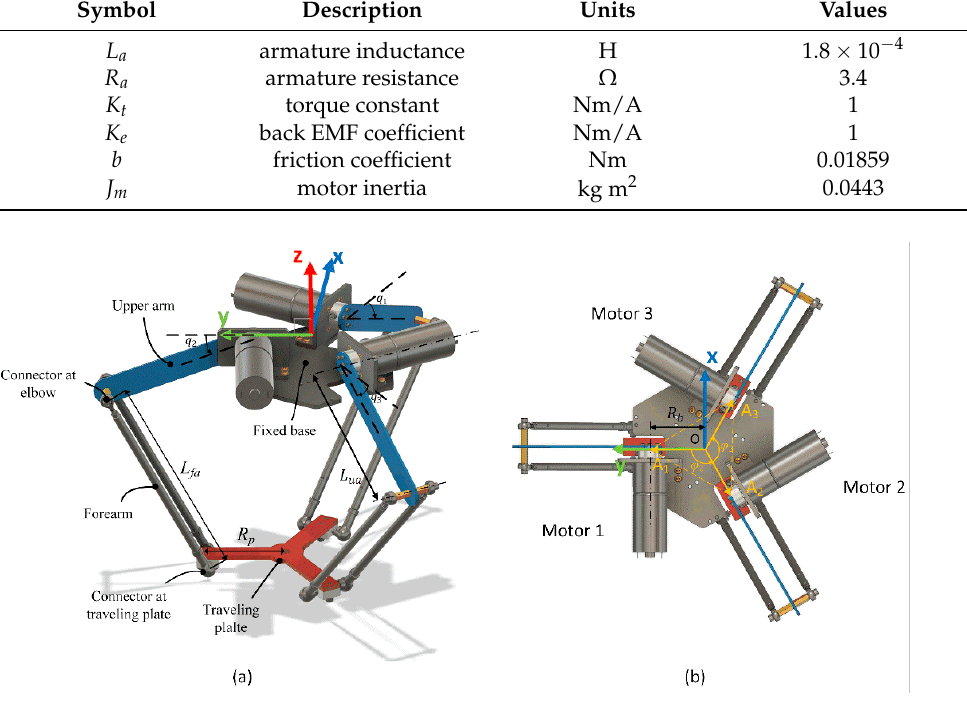
Figure 1. The Delta robot in 3D view ( a ) and top-view ( b ). Table 2. Kinematic and dynamic parameters of Delta manipulator.